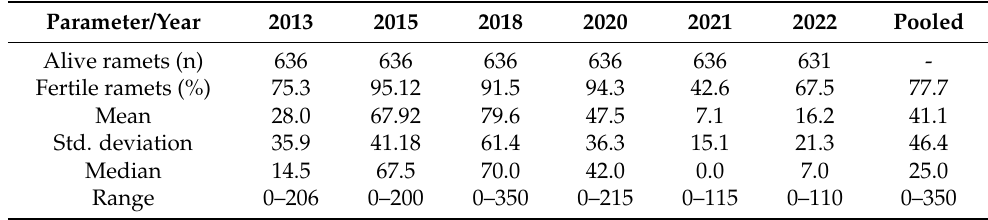
Table 2. Statistics of cones production across